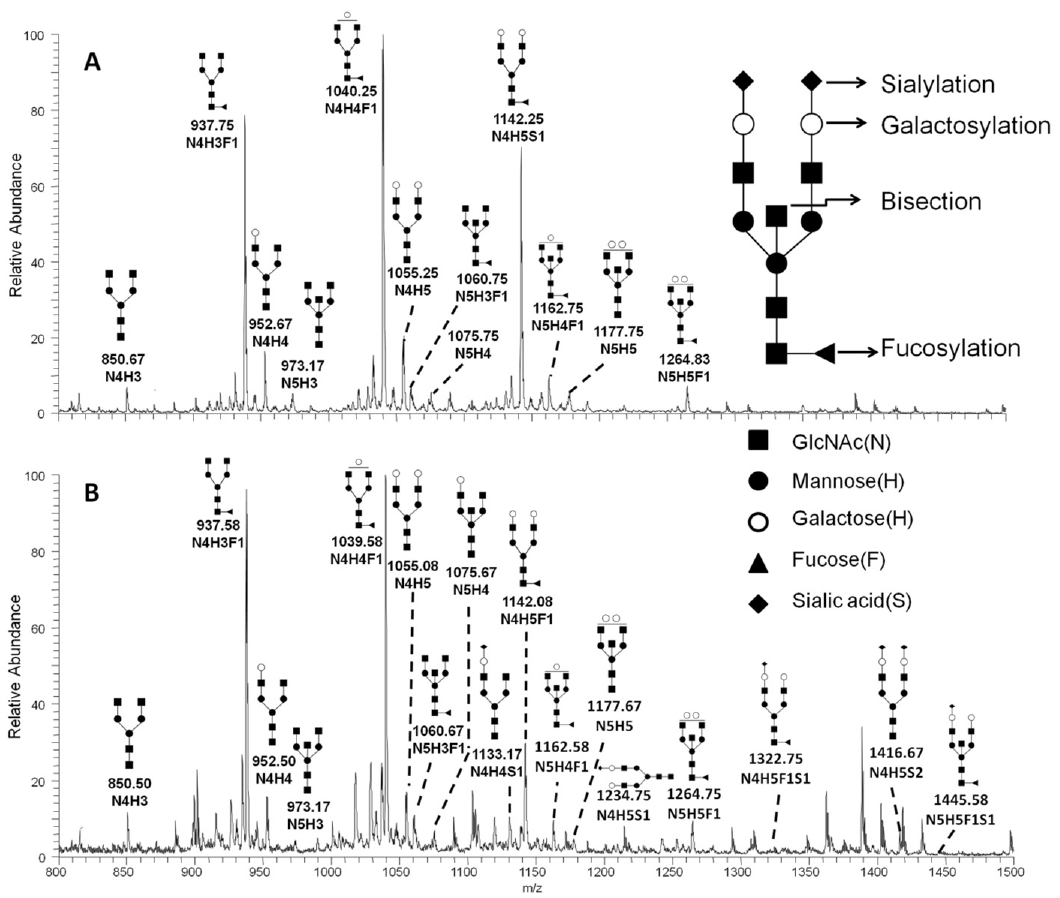
Figure 2. Representative MS 1 spectrums of N-glycans from healthy control Immunoglobulin G (IgG) ( A ) and rheumatoid arthritis patient IgG ( B ). The representative structure of IgG Fc N-glycan is shown. Based on the core structure (GlcNAc2-Man3-GlcNAc2), galactoses (H, lighter circle), Mannose (H, solid circle), bisecting GlcNAc (N, diamond), sialic acids (S, rhombus), or fucose (F, triangle) can be attached.